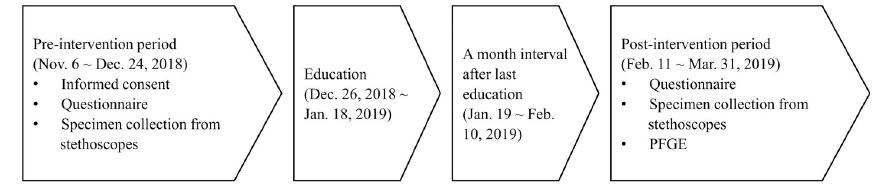
Fig 1. Study flow for pre and post quasi-experimental study. PFGE, Pulsed-field gel